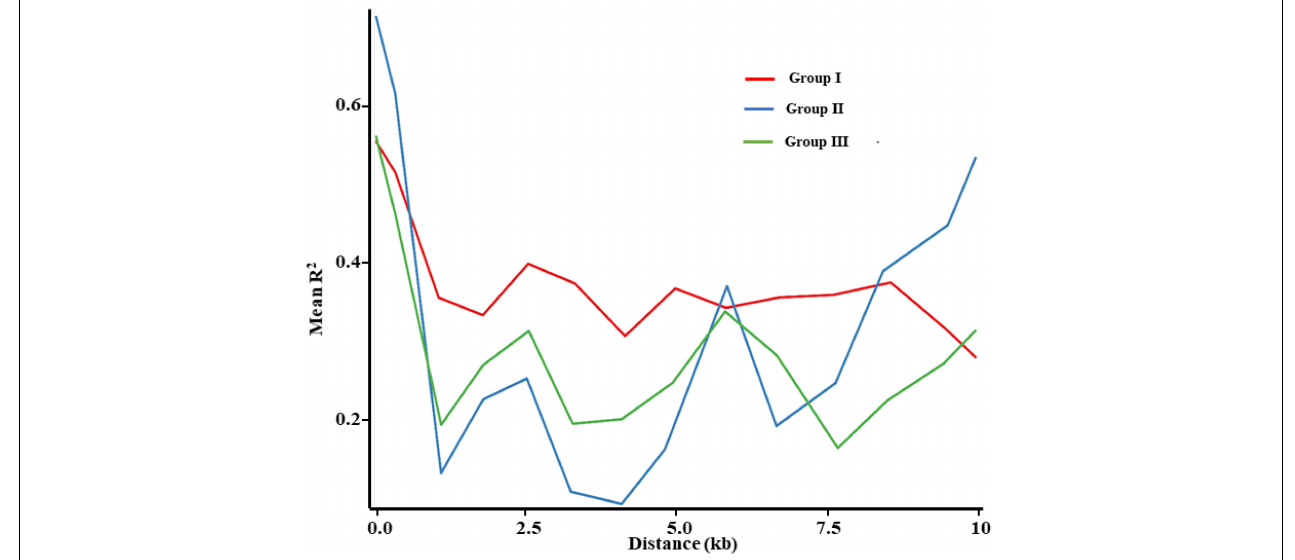
FIGURE 8 | Decay of average linkage disequilibrium (LD) over distance among SNPs in E. sibiricus populations.